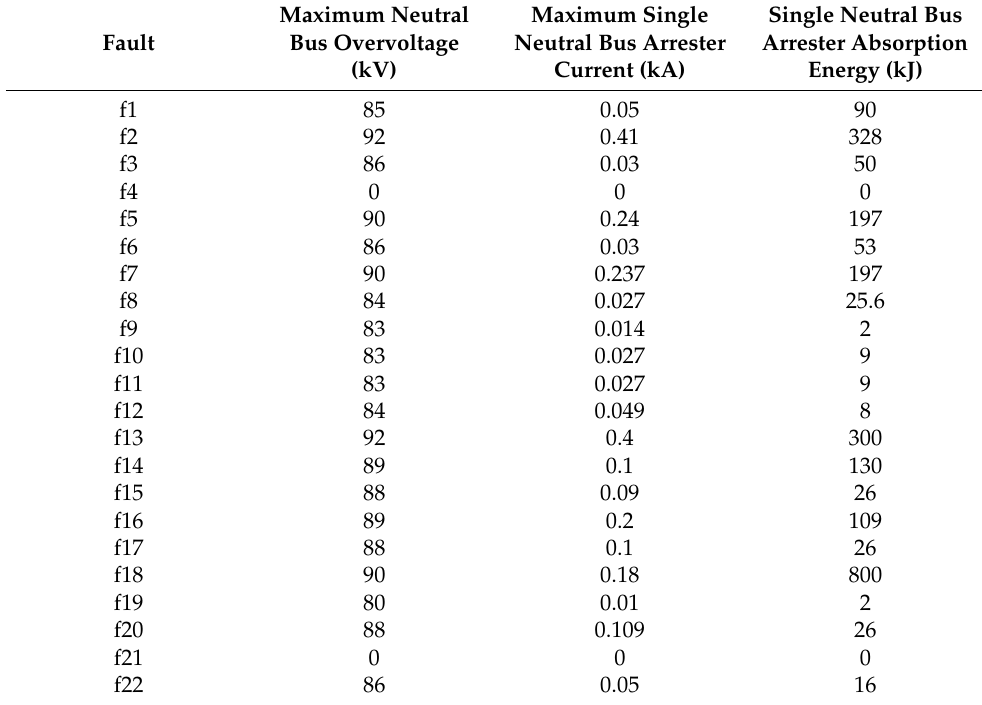
Table 6. Arrester voltage, current, and energy of different fault conditions under the monopole earth loop